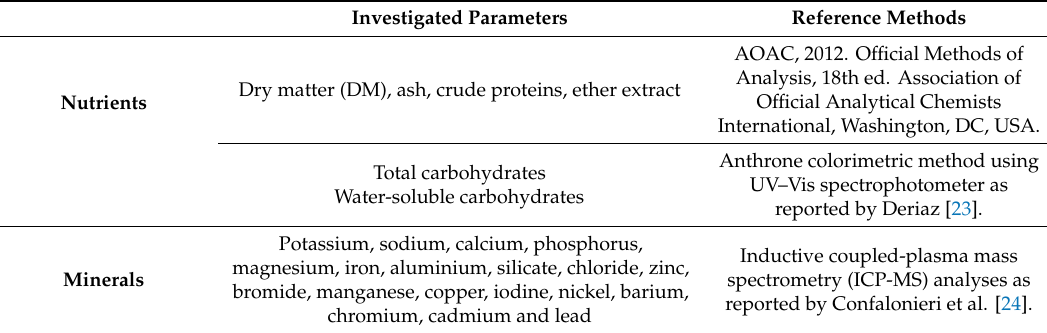
Table 1. Summary of nutritional, chemical, and microbiological parameters evaluated.